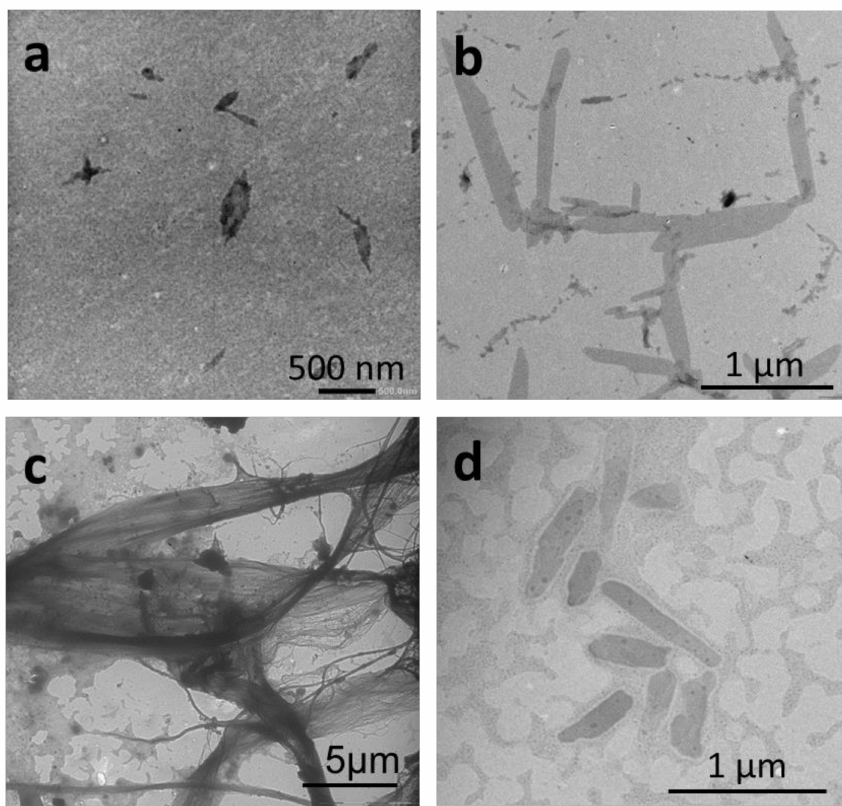
Figure 3. TEM images of self-assembled structures obtained by micellization of 1 mg mL − 1 solutions of the P(VDF- co -HFP)- b -PEG- b -P(VDF- co -HFP) triblock copolymer in ( a ) DMF, ( b ) acetone, employing ethanol as a selective solvent for PEG; and ( c ) DMF, ( d ) acetone, employing water as the selective solvent for PEG. Final concentration of all samples = 0.14 mg mL − 1 , solvent: selective solvent final ratio =